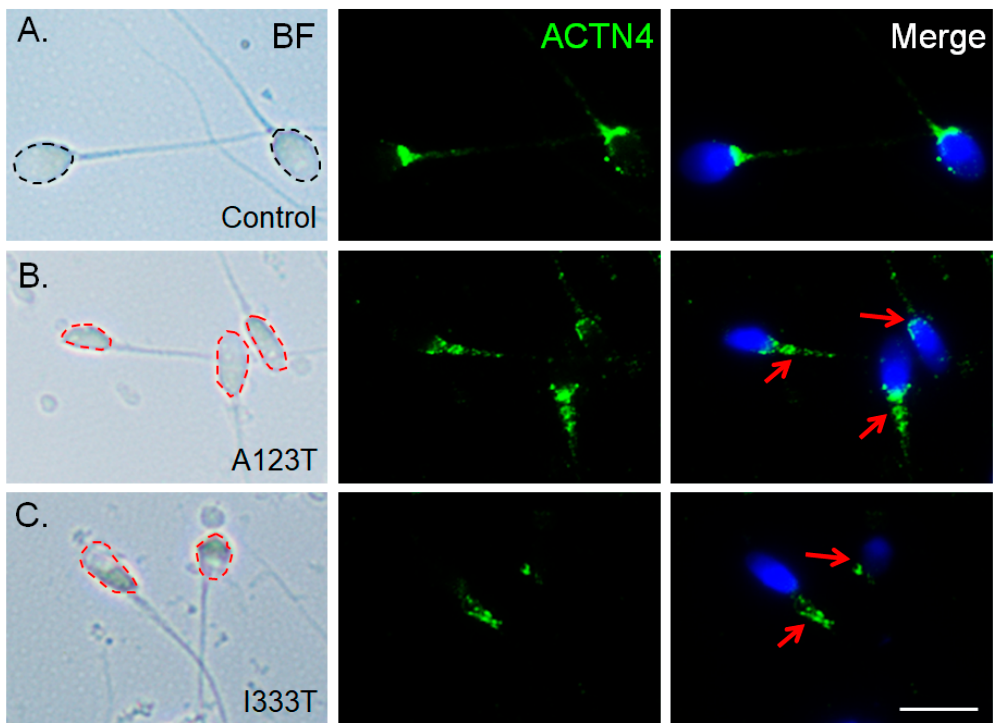
Figure 6. Immunofluorescence staining of ACTN4 in sperm from donors with SEPT14 mutations. ( A – C ) From left to right: bright field (BF), ACTN4 antibody staining (green), and merged DAPI and ACTN4 antibody staining. The figures from top to bottom show spermatozoa from donors with ( A ) WT-SEPT14 (Control), ( B ) SEPT14 A123T (A123T), and ( C ) SEPT14 I333T (I133T). The black and red dashed lines around the sperm indicate normal and abnormal sperm head morphologies, respectively. The red arrows indicate fragmented ACTN4 signals. Scale Bar: 50 μ M.